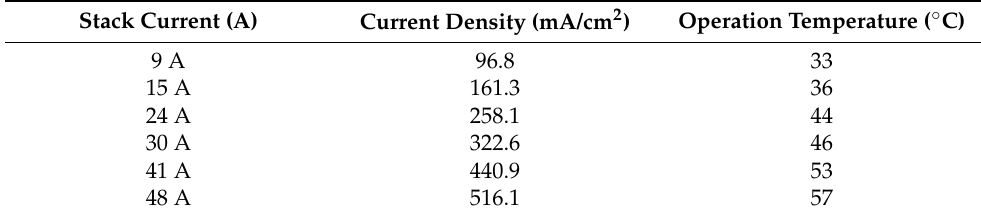
Table 2. Optimal operation temperature of a 2kW OC-PEMFC determined by the